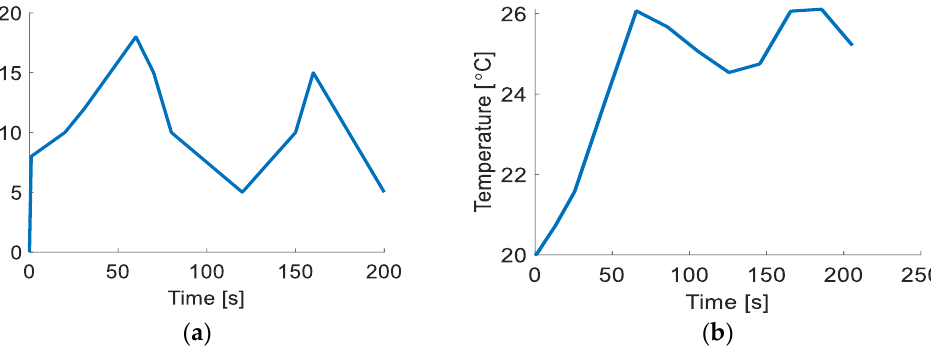
Figure 13. ( a ) Second custom drive current profile and corresponding ( b ) predicted temperature profile.